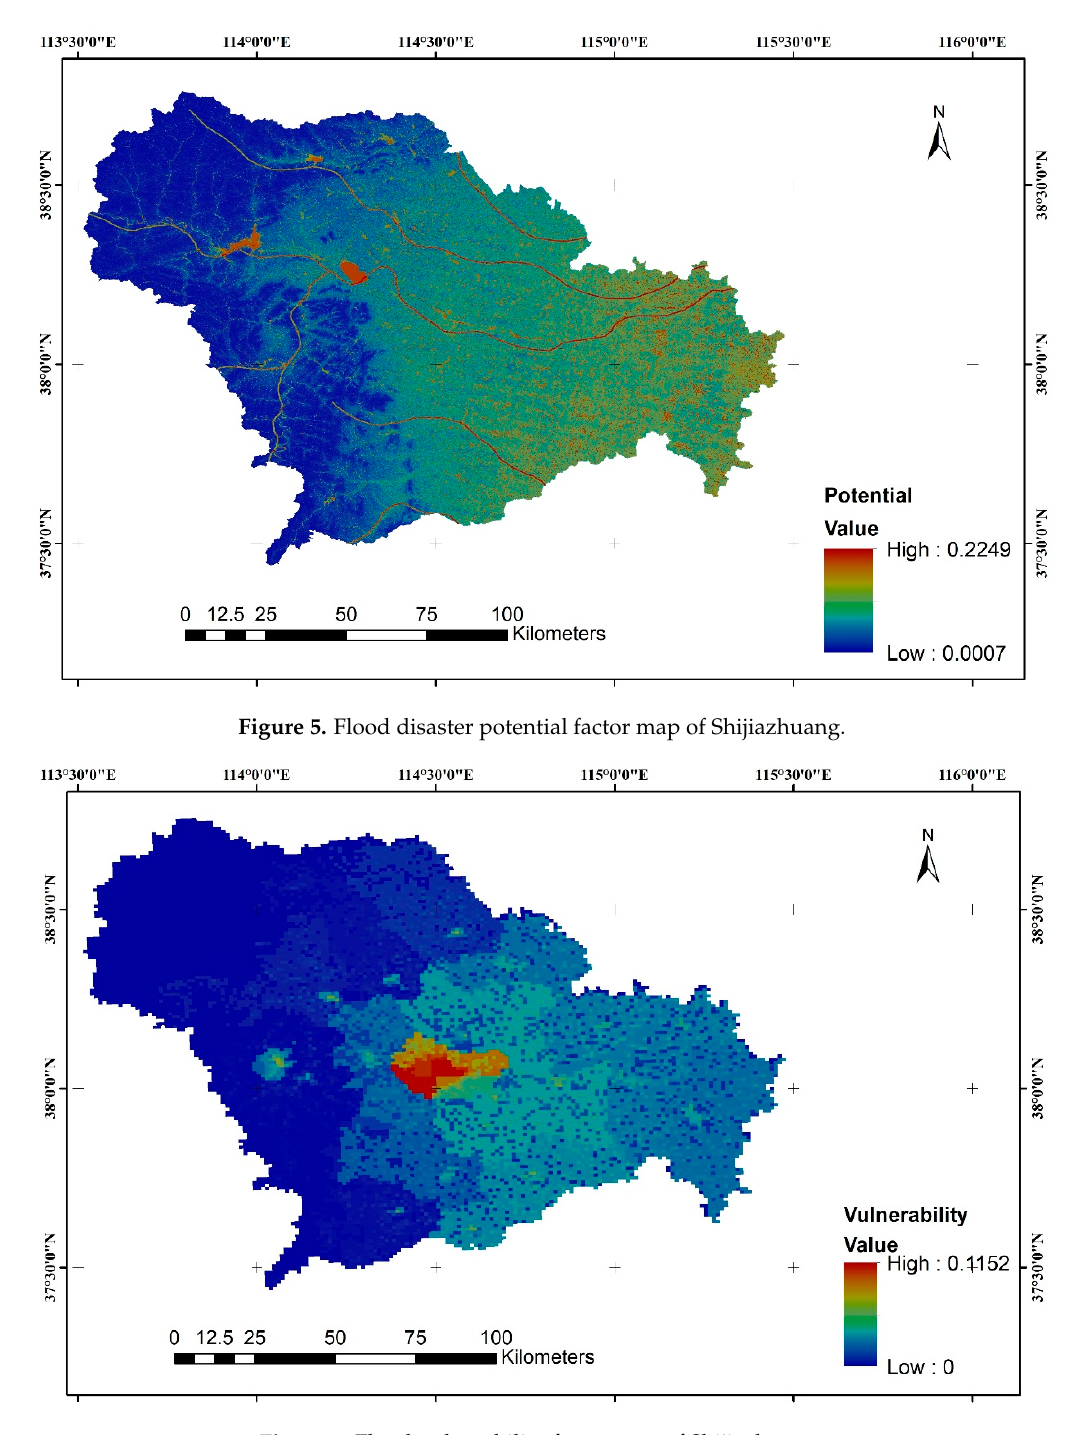
Figure 6. Flood vulnerability factor map of Shijiazhuang.